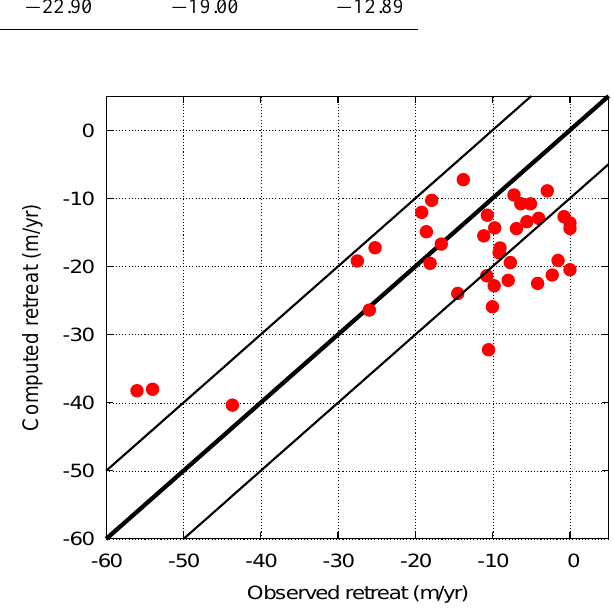
Fig. 13. Scatter-plot of observed retreat versus predicted retreat for the Parbati basin. The thinner lines represent the band of uncertainty (10myr − 1